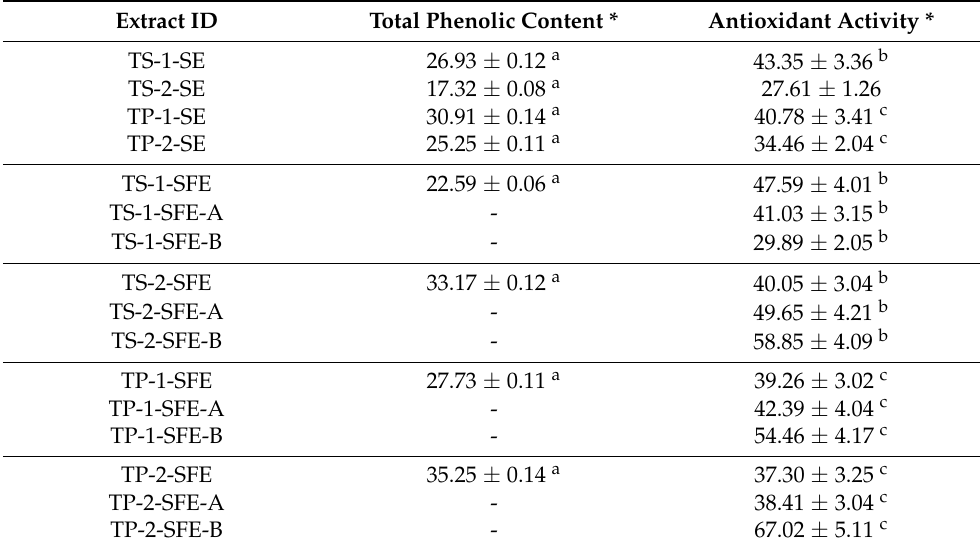
Table 6. Total phenolic content (mg GAE/g extract) ± SD and DPPH antioxidant activity (% inhibition ± SD) of tomato